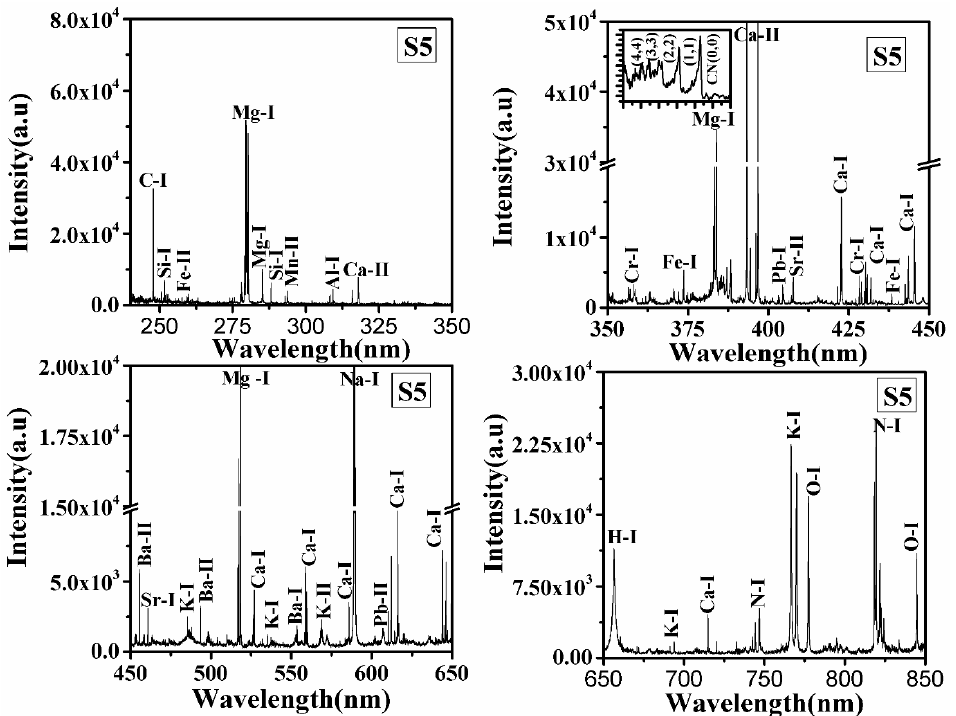
Figure 1. LIBS spectrum of turmeric sample (S5) in the spectral range from 240–350 nm, 350–550 nm, 450–650 nm, and 650–850 nm.